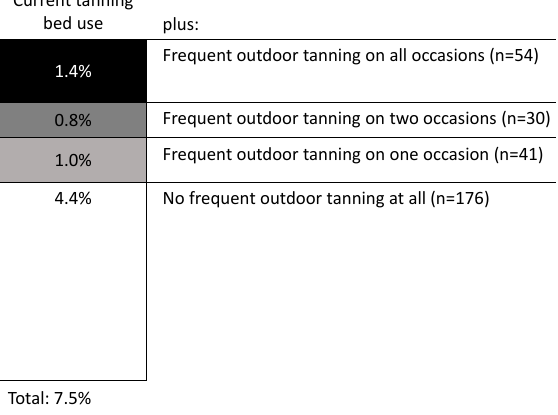
Figure 1. Combination of current tanning bed use with outdoor tanning.